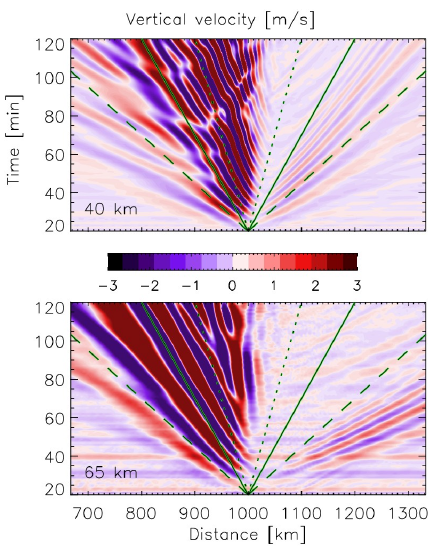
Figure 2. Vertical velocity, w (ms − 1 ), as a function of time ( y axis) and space ( x axis) at 40km (top image) and 65km (bottom im- age) of altitude. Slopes of isophases give a rough estimate of hor- izontal phase velocity of wave packets. As reference, dark green lines overplotted on figures show horizontal velocity slopes relative to 16.7ms − 1 (dotted), 33.3ms − 1 (solid) and 66.7ms − 1 (dashed) (i.e. 60, 120, 240kmh − 1 ,